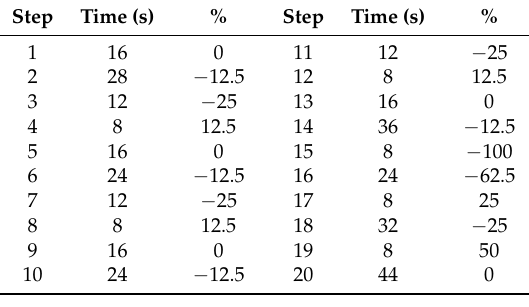
Figure 1. Test system of D 2 SADT.